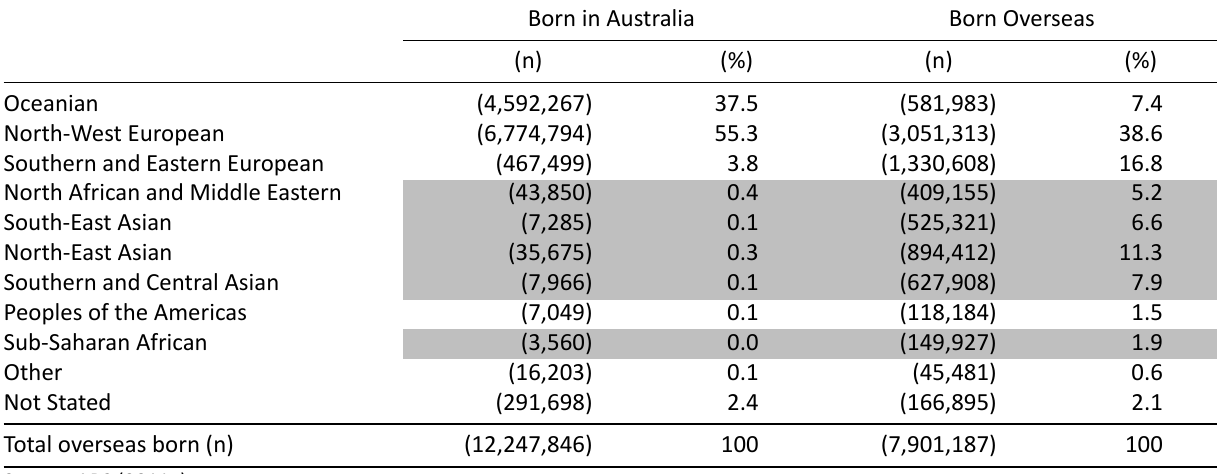
Table 3. First mentioned ancestry origins of the Australian population,